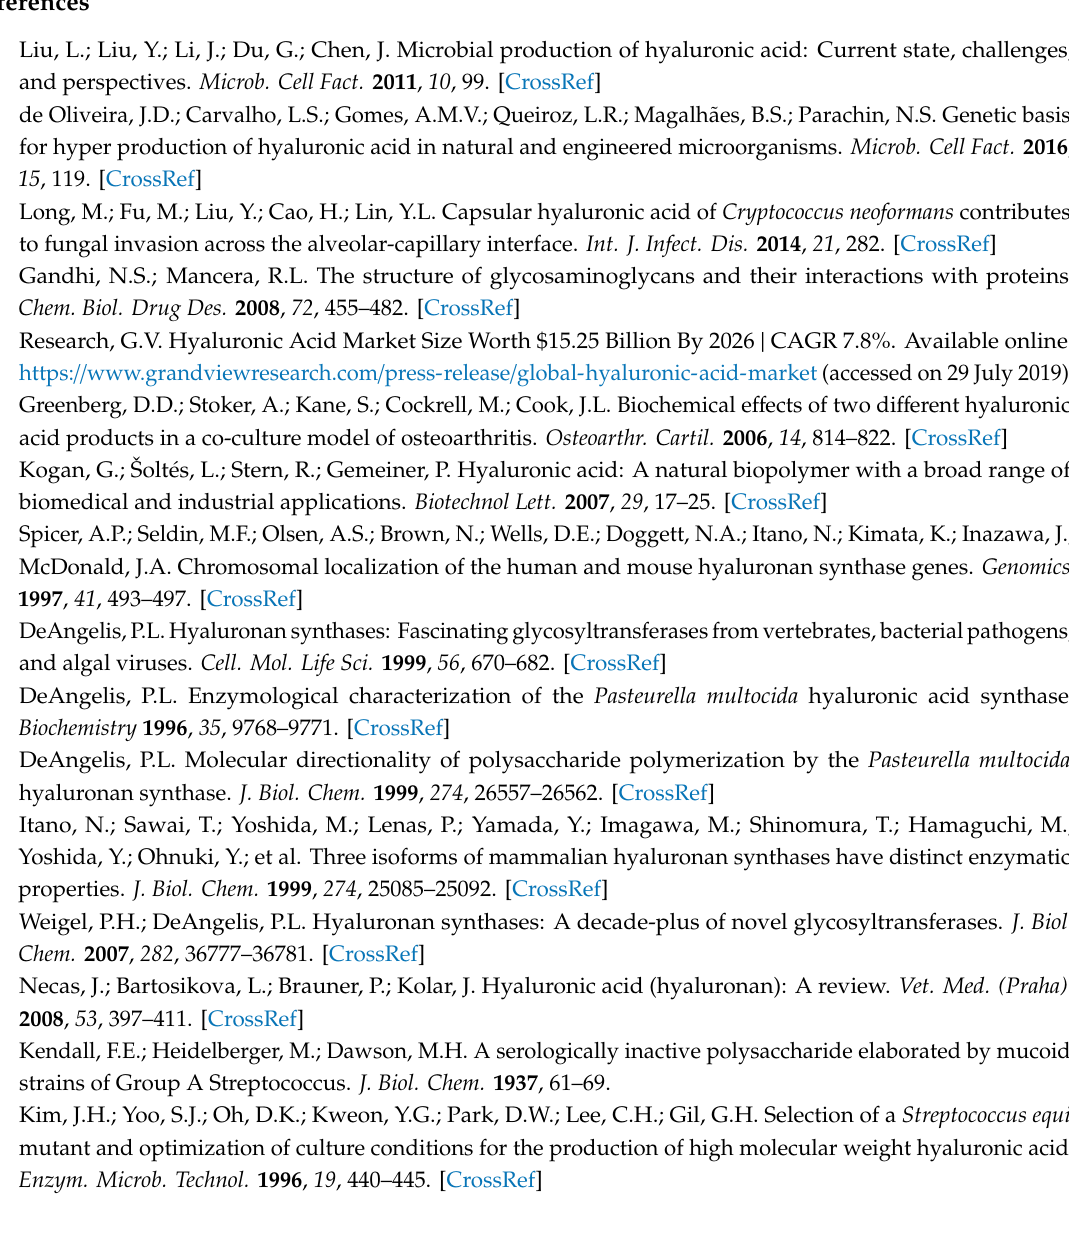
Figures S12 and S13: RNA integrity gels, Figures S14 to S18: Melt Curve Analysis, Figure S19: Kinetic Growth of strains, Figure S20: Transcripts level analysis, Figure S21: Copy Gene Number Analysis, Figure S22: GPC Analysis of Standard HA, Figure S23: Carbazol standard